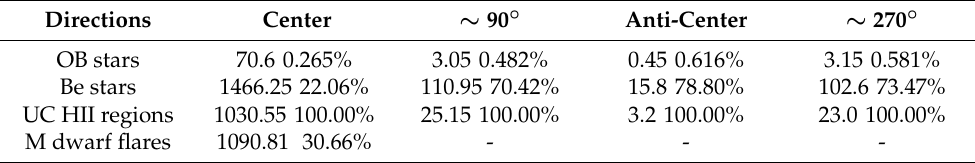
Table 2. The number of detectable sources (above 10 nJy) per square degree in different